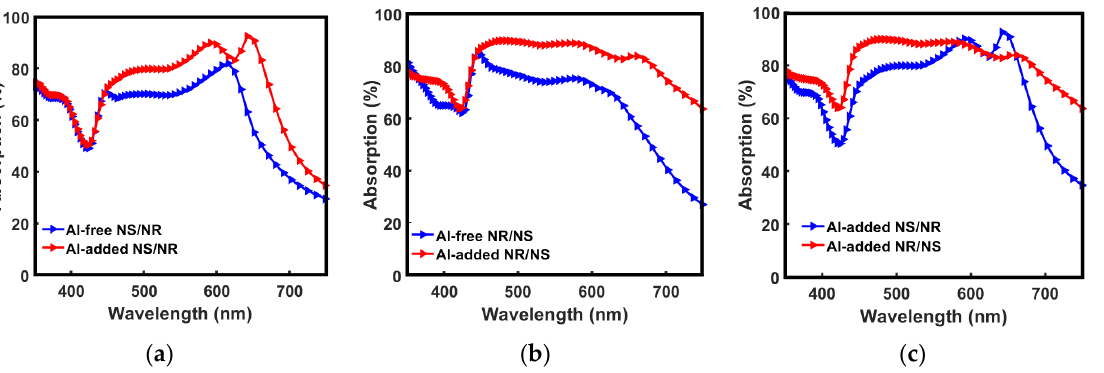
Figure 6. UV-Vis absorption spectrum of bilayer photoanodes based on SiO 2 with and without Alu- minum nanoparticles. ( a ) Nanospheres/Nanorods, ( b ) Nanorods/Nanospheres, ( c ) Both Nano- spheres/Nanorods and Nanorods/Nanospheres.